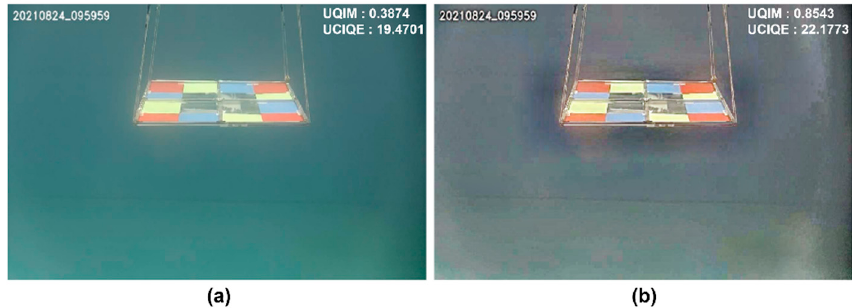
Figure 9. Single optical image enhancement, ( a ) original underwater optical image and ( b ) its enhanced image by image fusion.